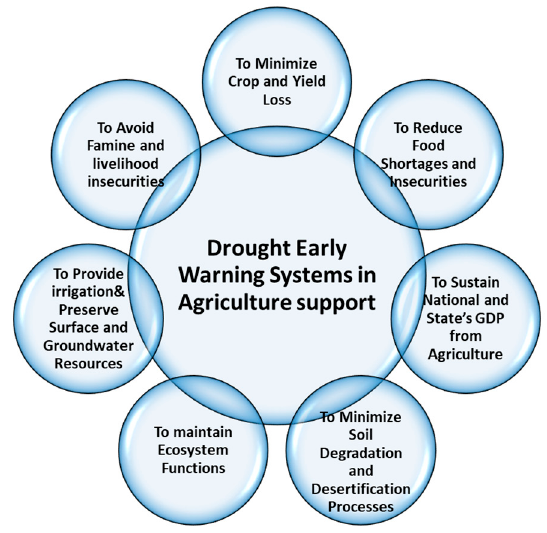
Figure 2. The significance of DEW as a weather smart option in climate change and agriculture adaptation (CCAA) (Source: Author Formulated).